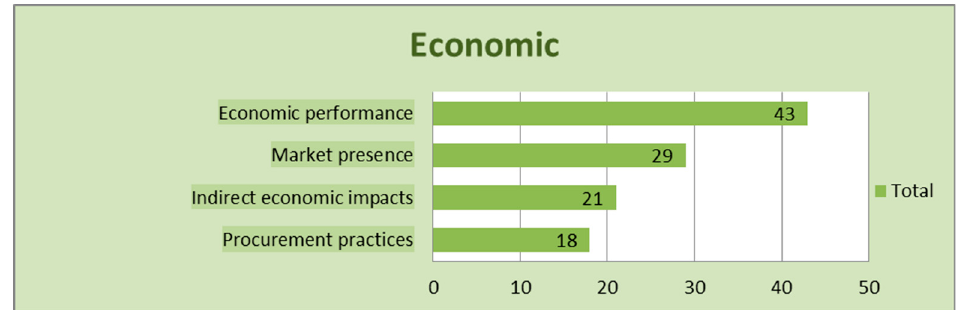
Figure 6. Tallies of occurrence of the economic sustainability indicators.